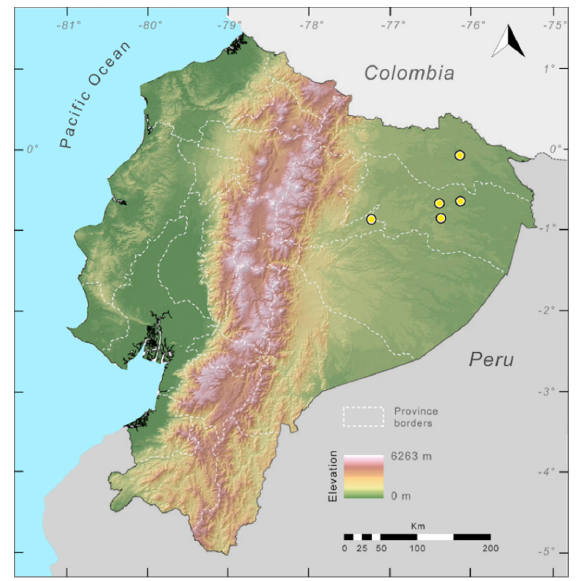
Figure 226. Distribution of Teratohyla ritae in Ecuador (yellow dots).